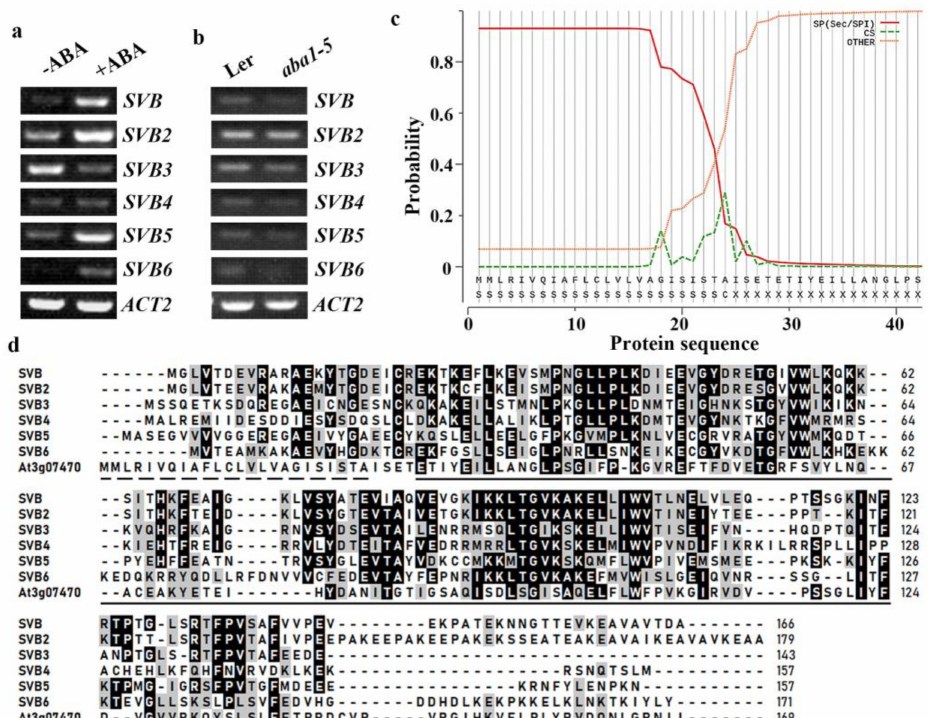
Figure 1. SVB is an ABA response gene and is closely related to other 5 SVBs . ( a ) Expression of SVBs in response to ABA. Twelve-day-old Col wild type seedlings were treated with 50 µ M ABA for 4 h, RNA was isolated, and RT-PCR was used to examine the expression of SVBs . The expression of ACT2 was used as a control. ( b ) Expression of SVBs in the ABA biosynthesis mutant aba1-5 . RNA was isolated from 12-day-old Ler wild type and aba1-5 mutant seedlings, and RT-PCR was used to examine the expression of SVBs . The expression of ACT2 was used as a control. ( c ) Signaling peptide prediction of At3g07470. The full-length amino acid sequence of At3g07470 was used for signal peptide prediction on SignalP (http://www.cbs.dtu.dk/services/SignalP, accessed on 4 June 2021). ( d ) Amino acid alignment of SVBs and At3g07470. The full-length amino acid sequences of SVBs and At3g07470 were obtained from phytozome (https://phytozome.jgi.doe.gov/pz/portal.html#, accessed on 4 June 2021) and sequence alignment was performed by using BioEdit 7.0 (https:// bioedit.software.informer.com/7.0/, accessed on 4 June 2021). The identical amino acids were shaded in black, and the similar ones in gray. Solid underline indicates the DUF538 domain. Dash underline indicates the signal peptide in